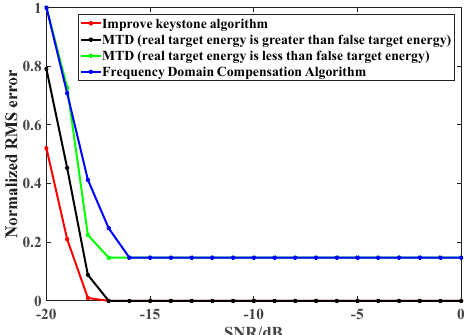
Figure 16. Comparison algorithm verification ( 25 Ma/30 Km ).